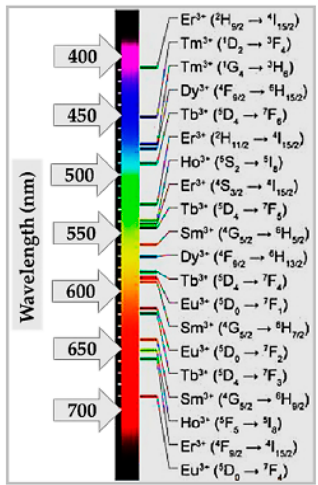
Figure 7. Diagram of the color output resulting from the main f-f transitions of RE elements.